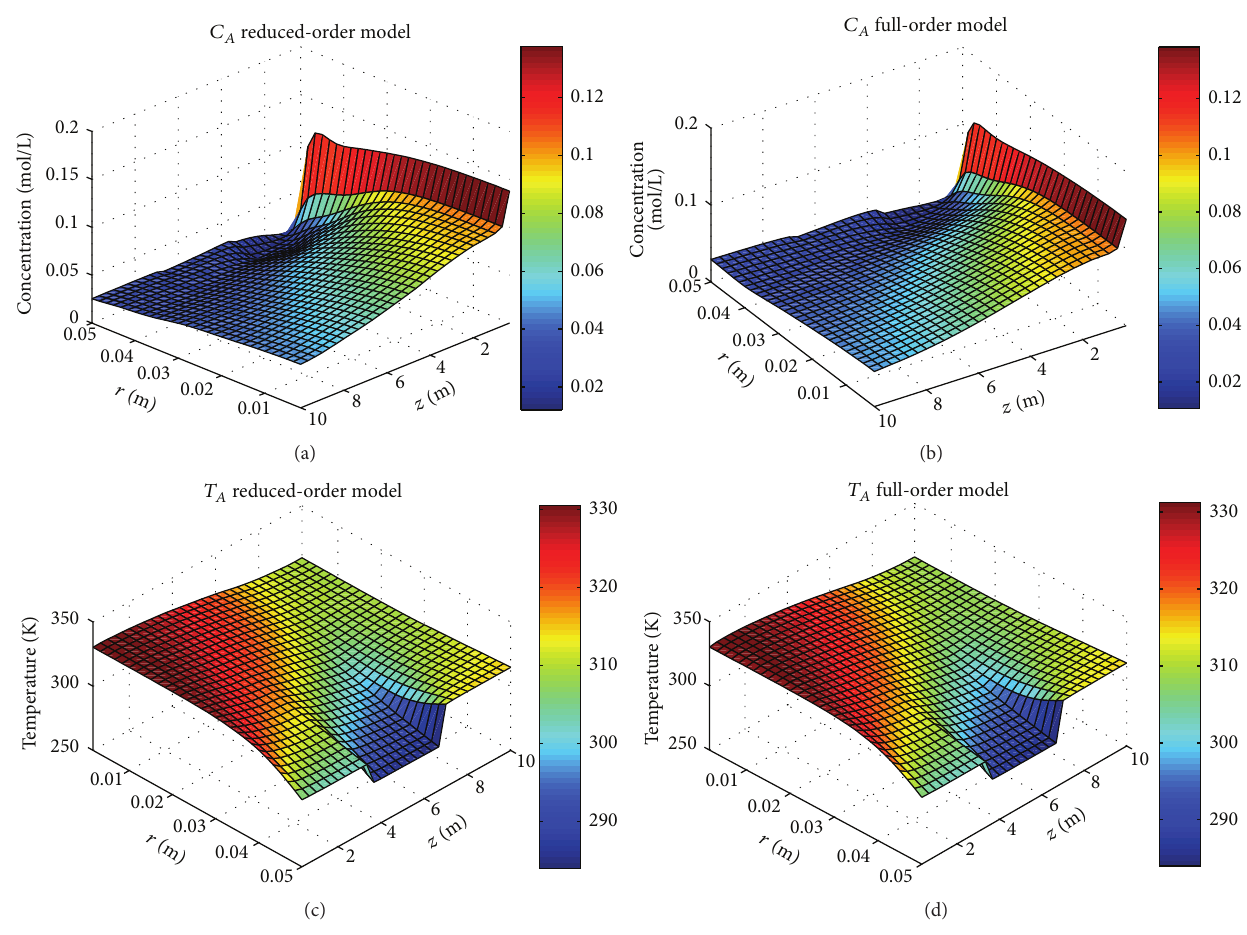
Figure 9: Temperature and concentration profiles at 𝑡 = 10000 s: full-order Model and reduced-order model.